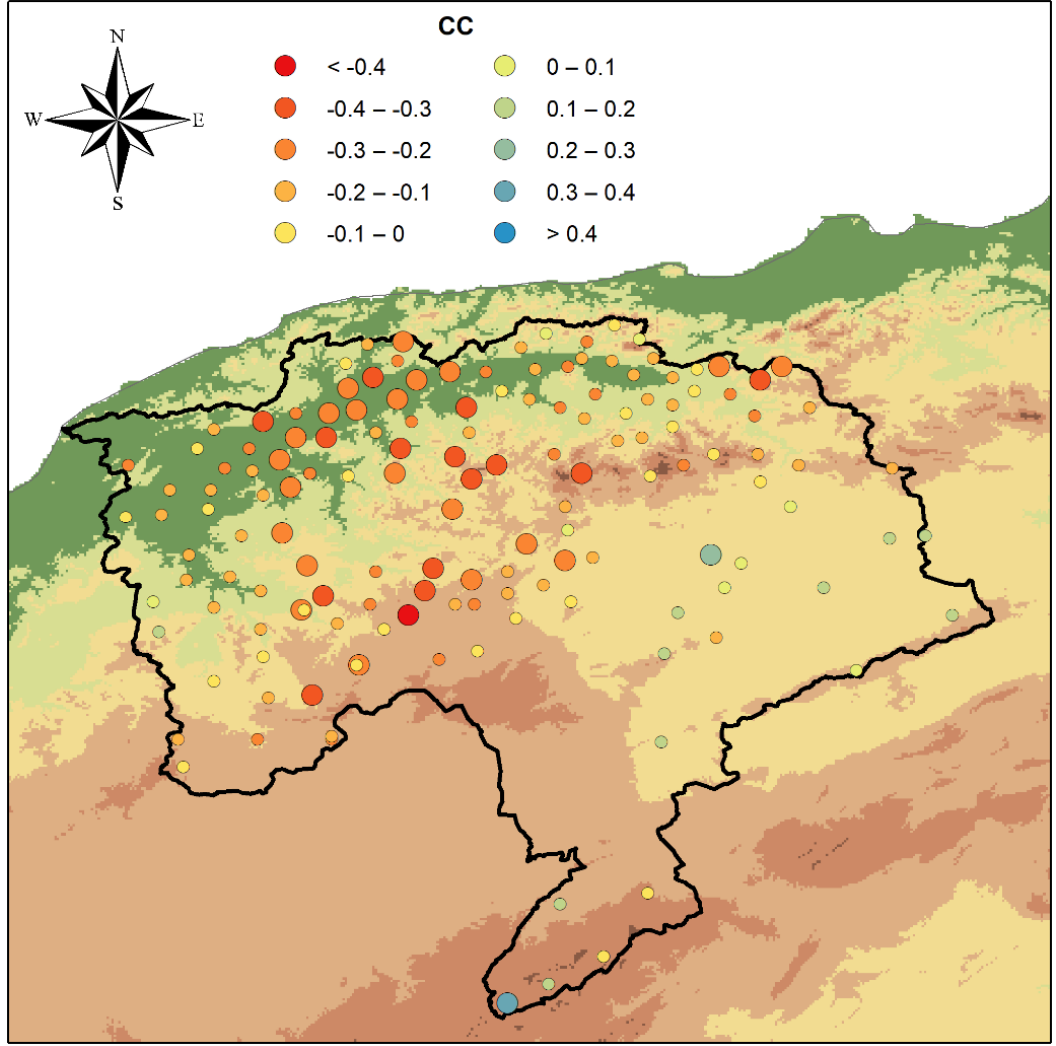
Figure 7. Spatial results of the correlation analysis computed, with the Pearson method and for each station, between the SPI values and the NAO. Large sized points reveal a significant correlation, while small points show non-significant correlations.